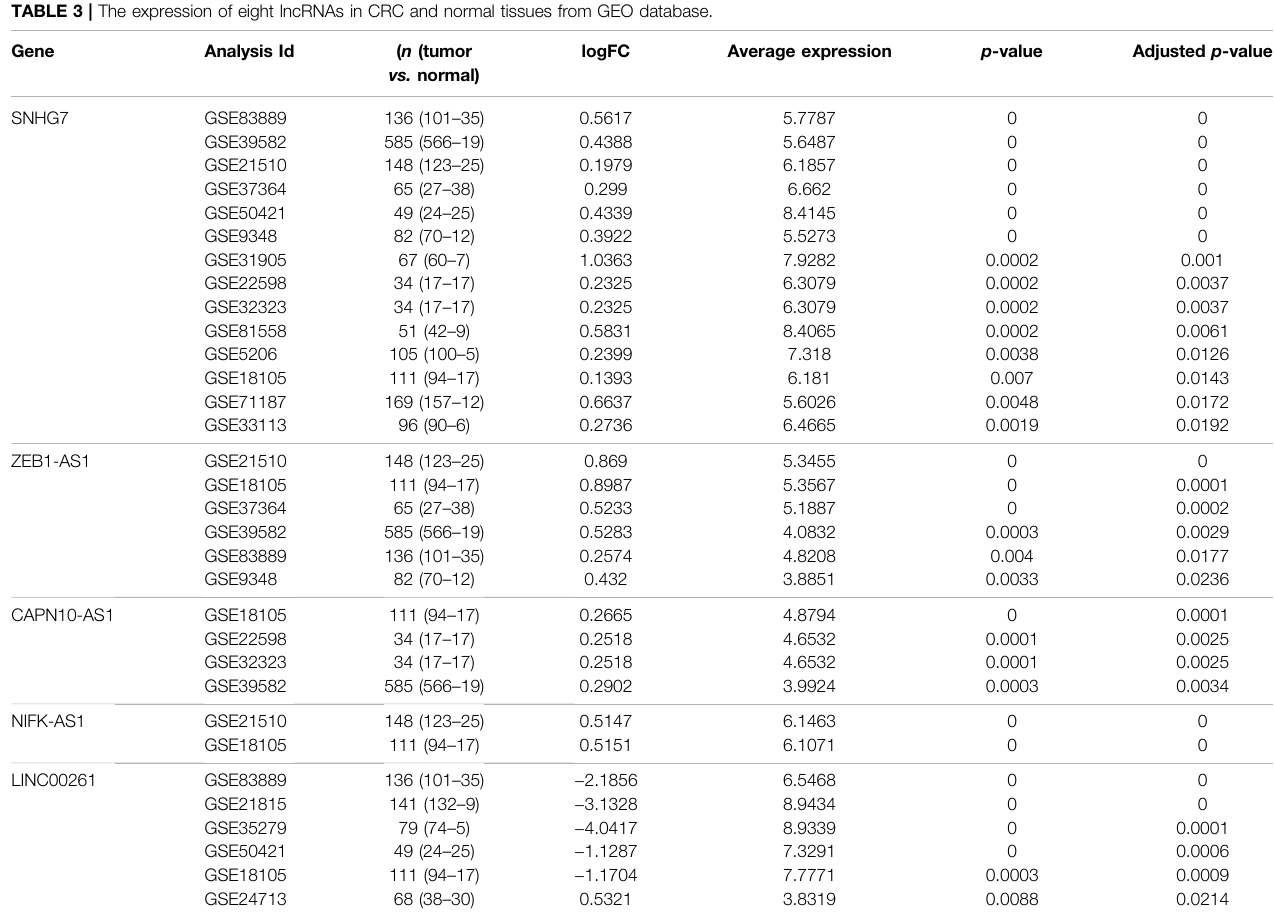
TABLE 3 | The expression of eight lncRNAs in CRC and normal tissues from GEO database. Gene Analysis Id ( n (tumor vs.